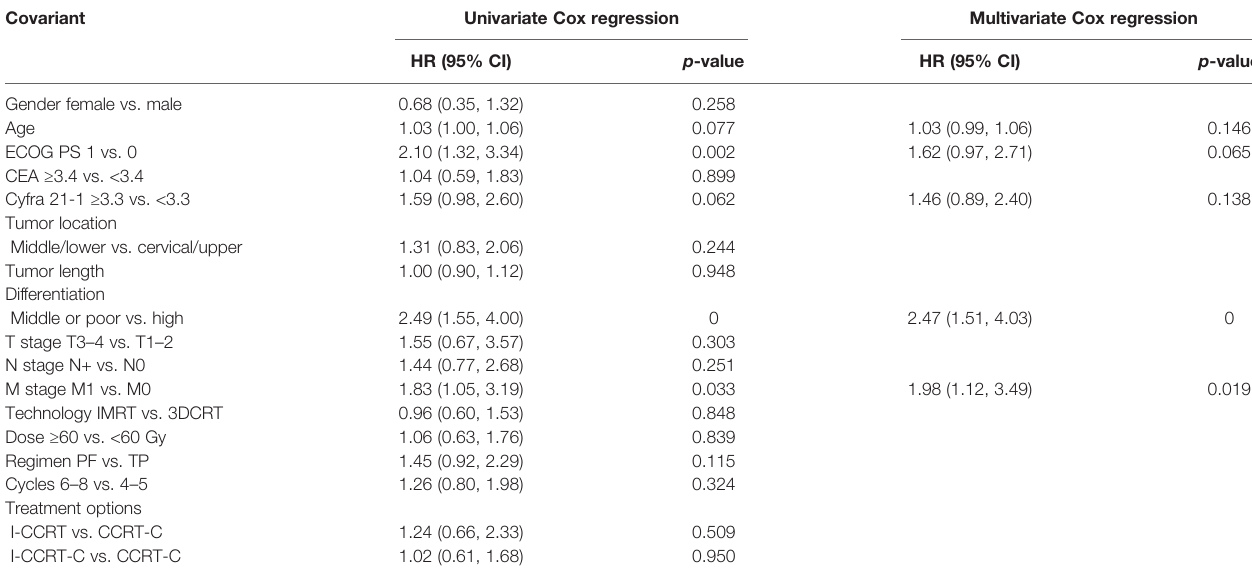
TABLE 4 | Univariate and multivariate Cox regression in predicting OS. Covariant Univariate Cox regression Multivariate Cox regression